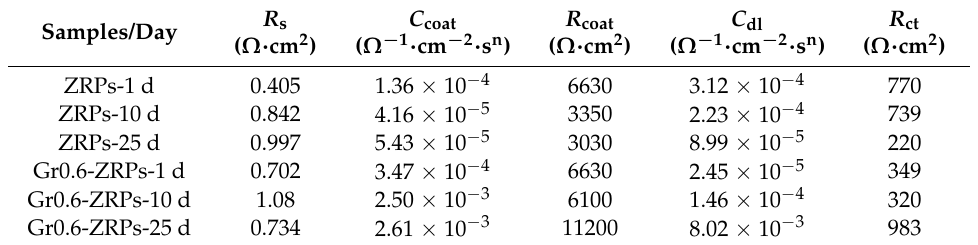
Table 2. Electrochemical impedance parameters fitted from the measured impedance plots in Figure 4. Samples/Day